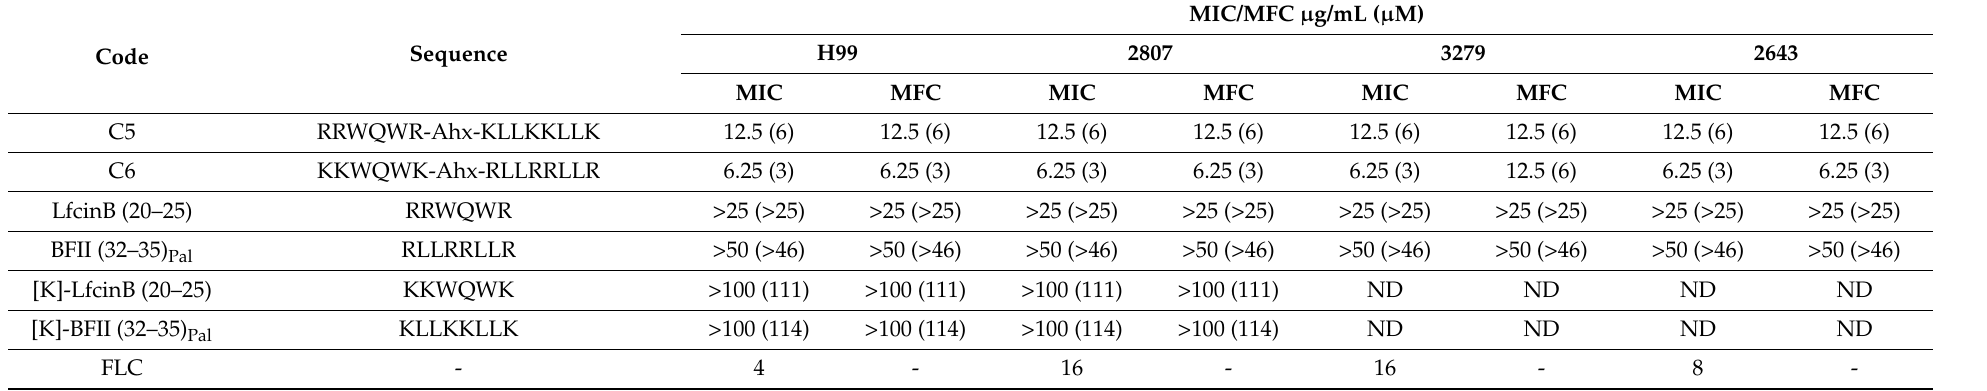
Table 1. Antifungal activity of fluconazole and peptides against C. neoformans var. grubii .